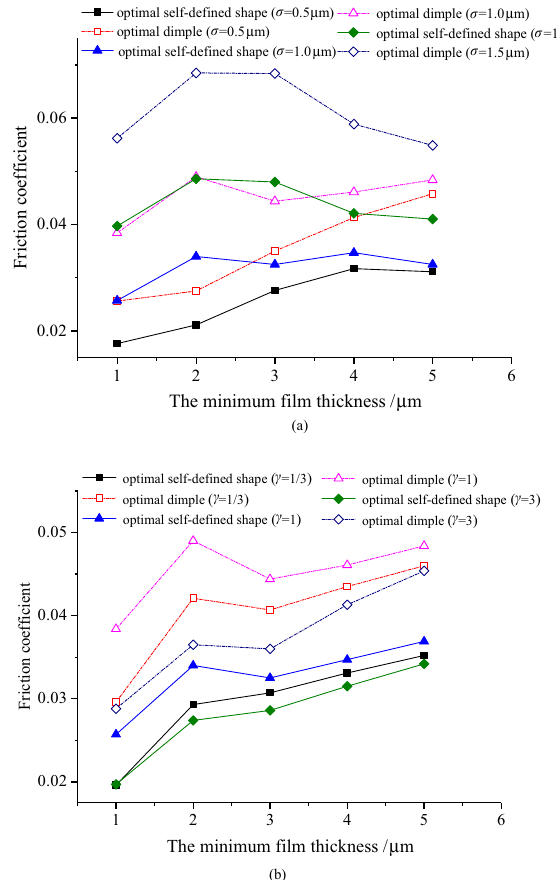
Figure 7. Variation of the friction coefficient with the minimum film